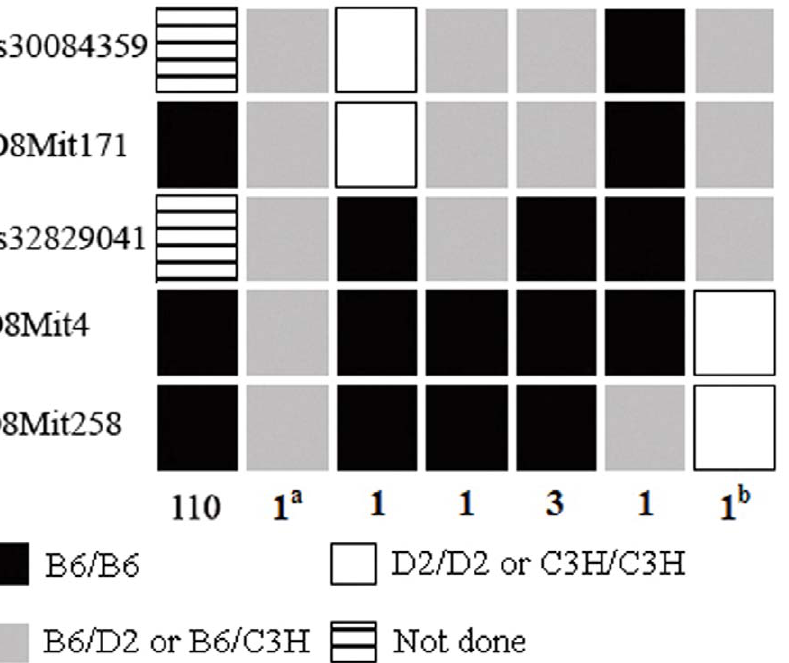
Figure 2. Genetic mapping places the mutant in the region between markers rs32829041 and D8Mit4. Primary markers used to refine the map position are listed on the left from the centromere (top), and the number of animals in each genotypic class is shown at the bottom. 1 a and 1 b : mice with unilateral and partially dilated pupil phenotypes. The others are mice with a severe bilaterally dilated pupil phenotype.